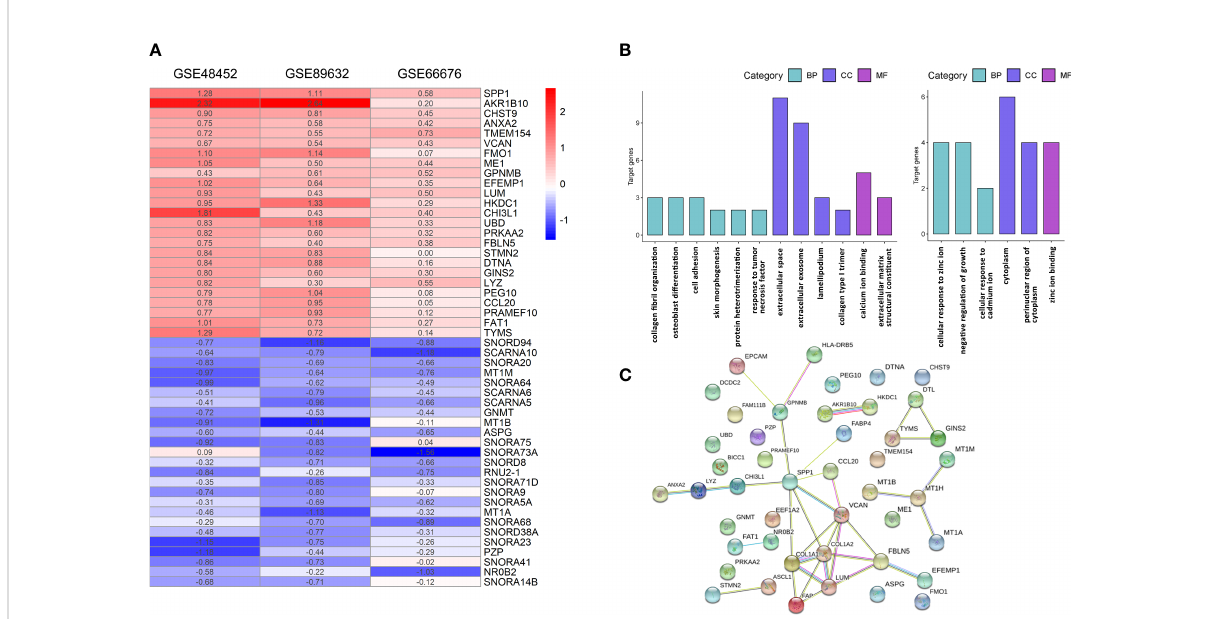
FIGURE 2 Integrative analysis of DEGs by RRA, functional enrichment, and PPI network. (A) Heatmap of the top 25 robustly upregulated or downregulated DEGs in RRA analysis. (B) GO annotation of upregulated (left panel) and downregulated (right panel) DEGs. (C) PPI networks of DEGs. BP, biological process; CC, cellular component; GO, gene ontology; MF, molecular function; PPI, protein – protein interaction; DEGs, differentially expressed genes; RRA, robust rank